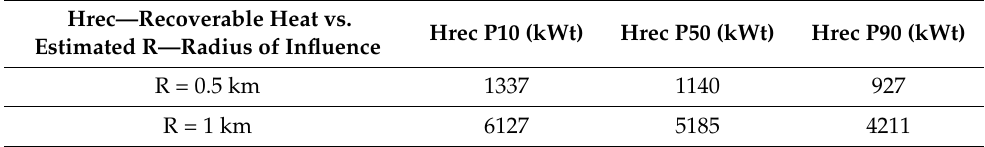
Table 2. Estimated probable heat recovery capacity as a function of the influence radius for a hypothetical geothermal doublet well in the Jurassic reservoir close to the Reus-1